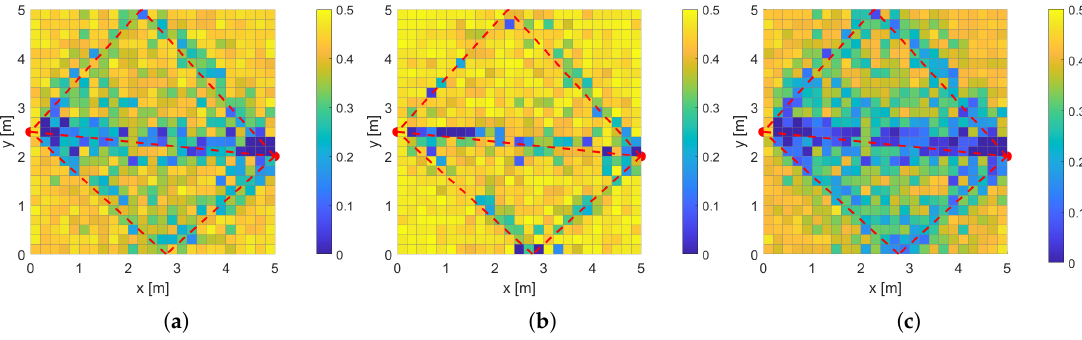
Figure 10. Simulated position error probability p E of the multipath-assisted DFL system with different feature vectors. The color coding represents p E . ( a ) Magnitudes only. ( b ) Phase differences only. ( c ) Combination of magnitudes and phase